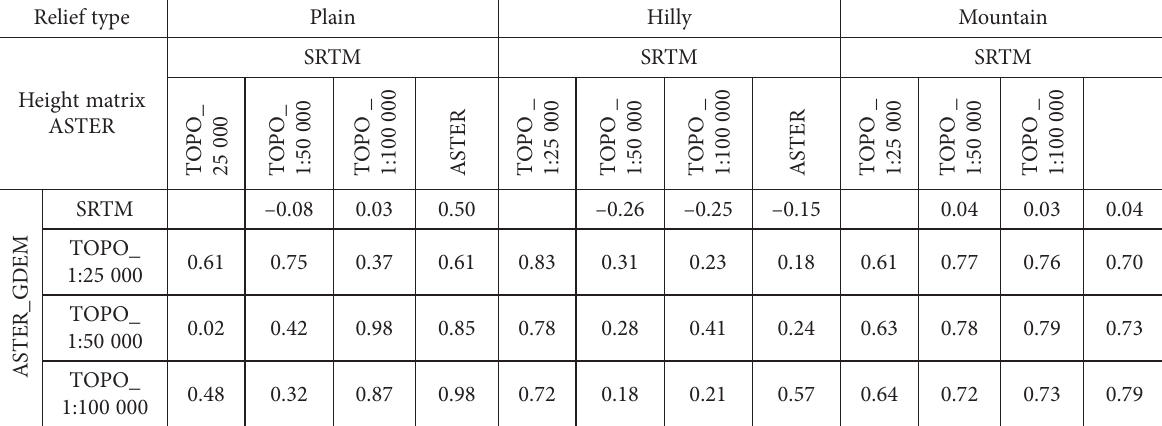
Table 5. The correlation matrix of raster difference surfaces by different sources of DTM data Relief type Plain Hilly Mountain